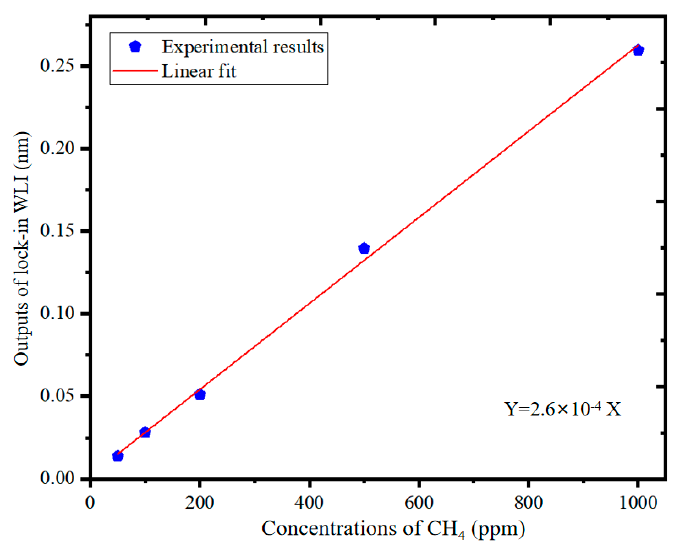
Figure 9. The output PA signals changing with different concentrations of CH 4 .